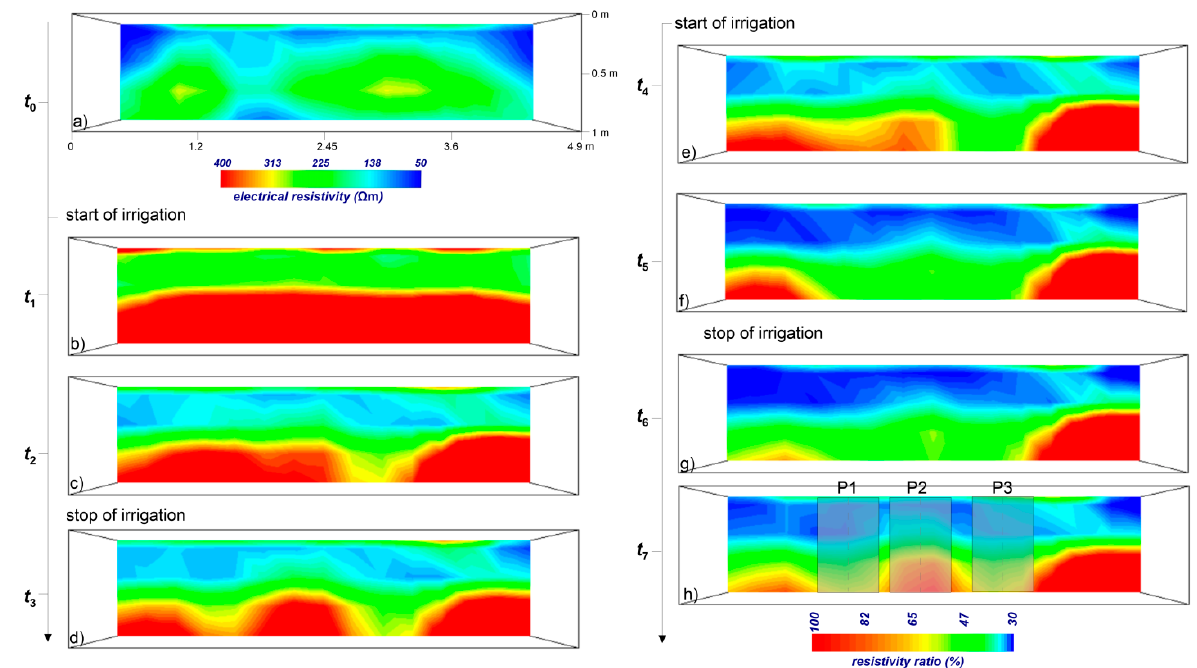
Figure 5. 2D ERT sections extracted at y = 2.4 m at the same time points shown in Figure 4. Times from t 0 to t 7 are related to: ( a ) ERT before irrigation (reference time t 0 ); ( b ) 54 min from t 0 ; ( c ) 257 min from t 0 ; ( d ) 643 min from t 0 ; ( e ) 1243 min from t 0 ; ( f ) 1453 min from t 0 ; ( g ) 1543 min from t 0 ; ( h ) 2113 min from t 0 .